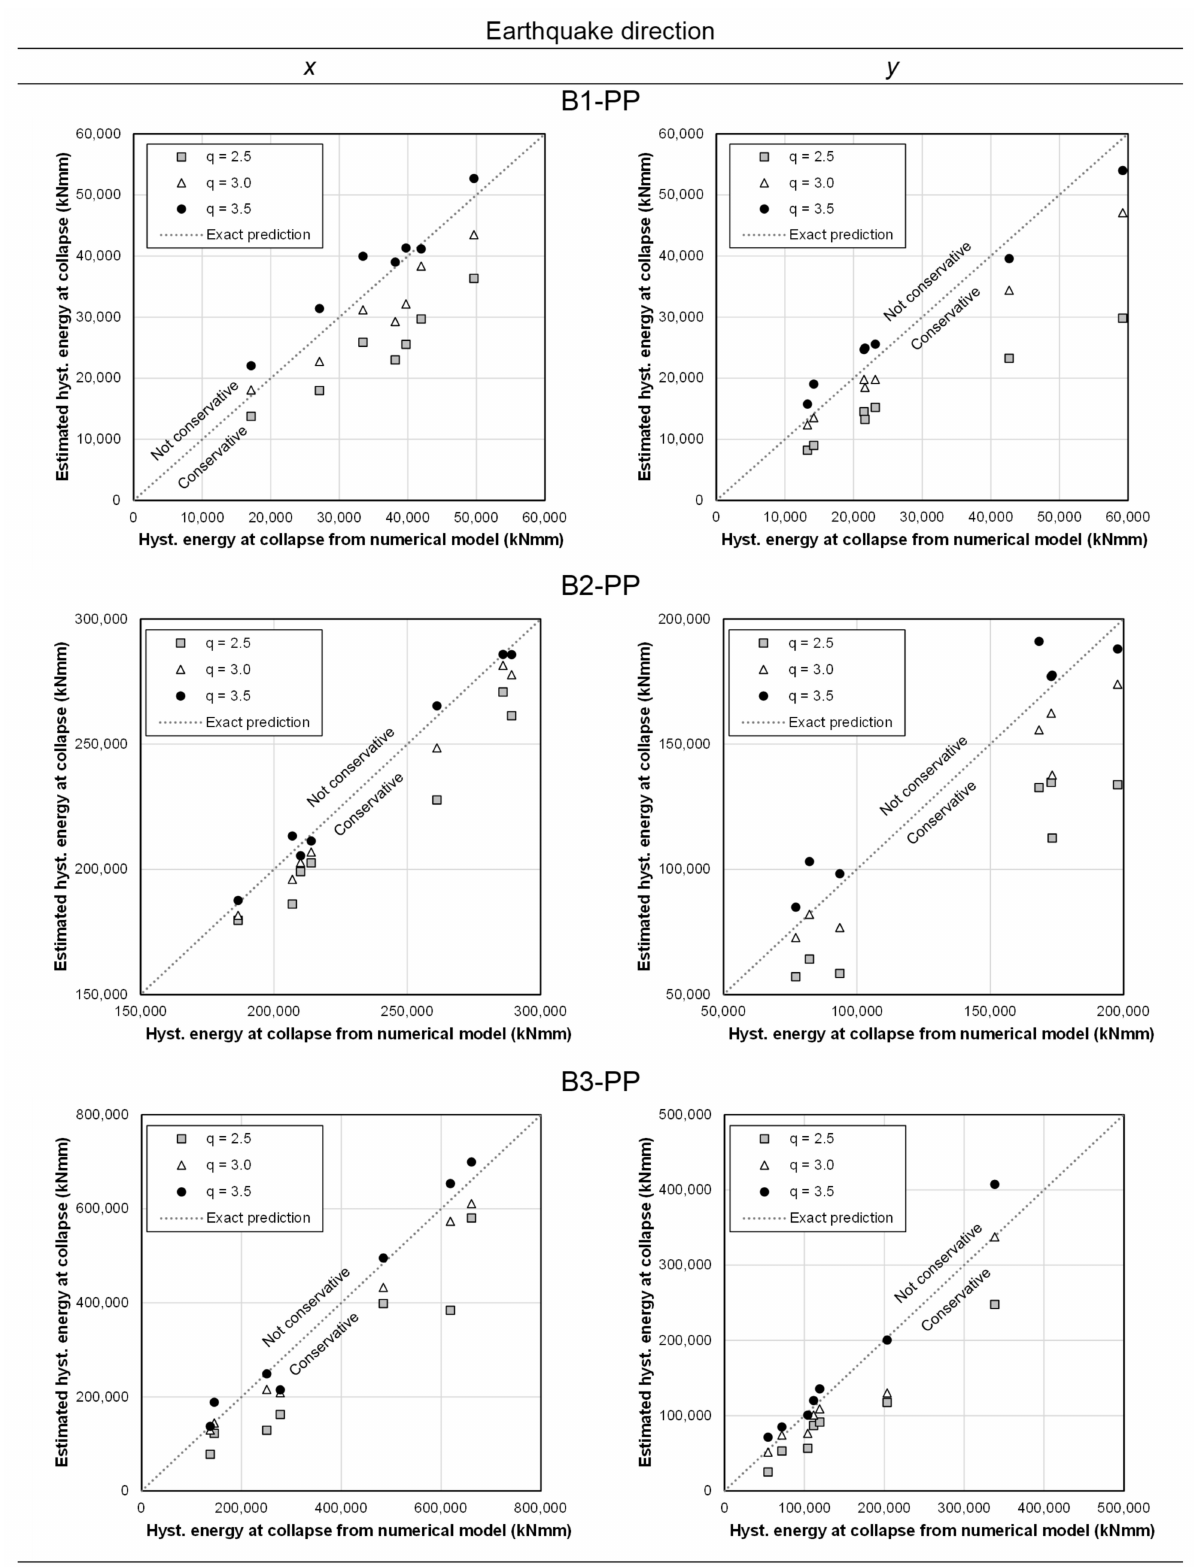
Figure 16. Hysteretic energy from the numerical model and predicted with Equations (1)–(3) for the plywood panel